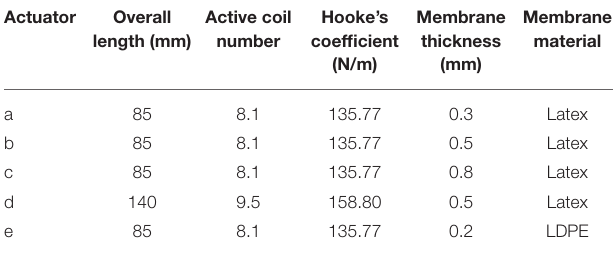
TABLE 2 | Parameters of five